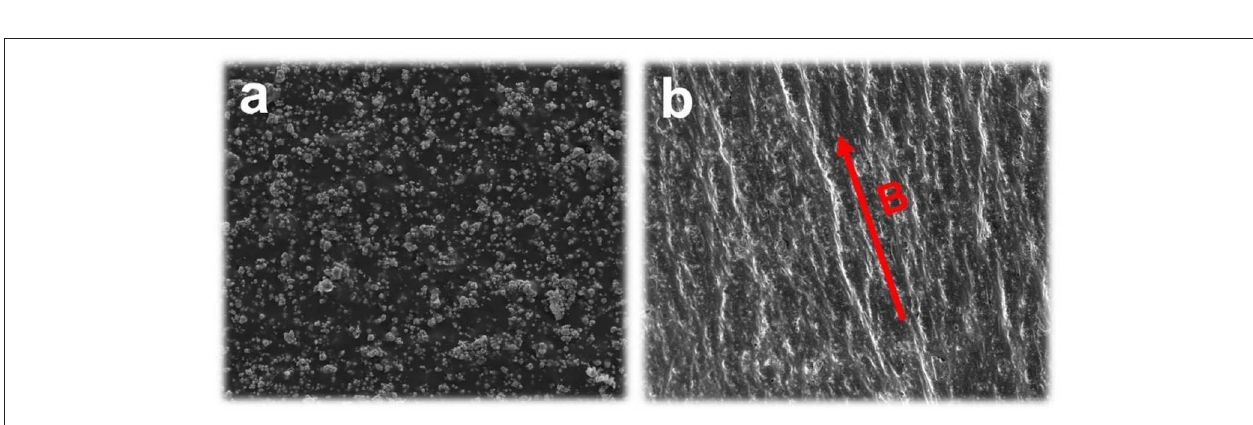
FIGURE 3 | SEM images of iso-IPN (a) and ani-IPN (b) . The red arrow indicates the direction of the pre-structure magnetic